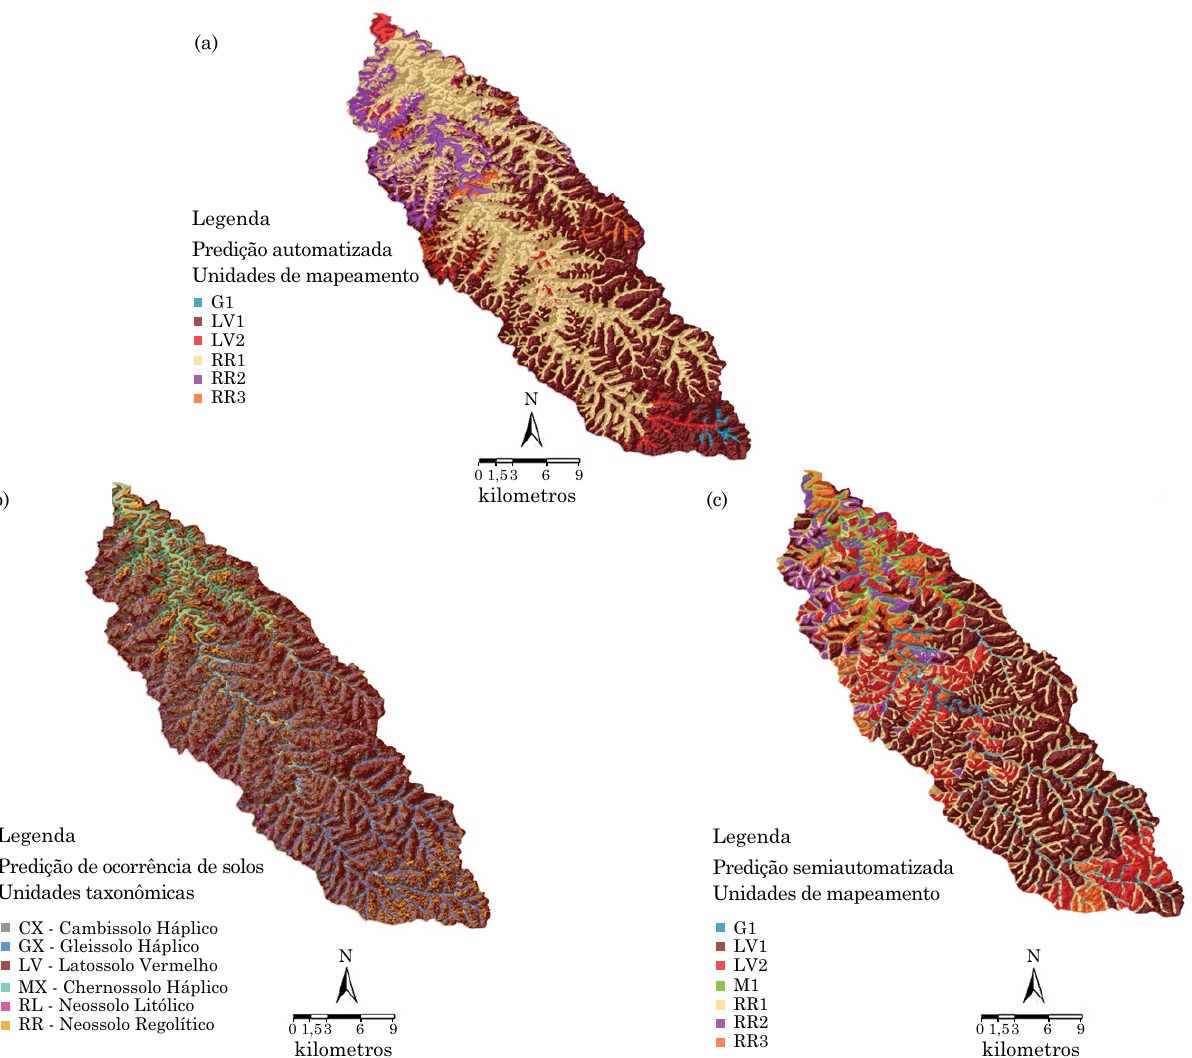
Figura 2. Mapa de unidades de mapeamento de solos gerado pelo método MDS direto (a); mapa intermediário de tipos de solos (b); e mapa de predição de ocorrência de unidades de mapeamento de solos delineadas a partir do mapa de predição de tipos de solo (método mds com delineamento manual)